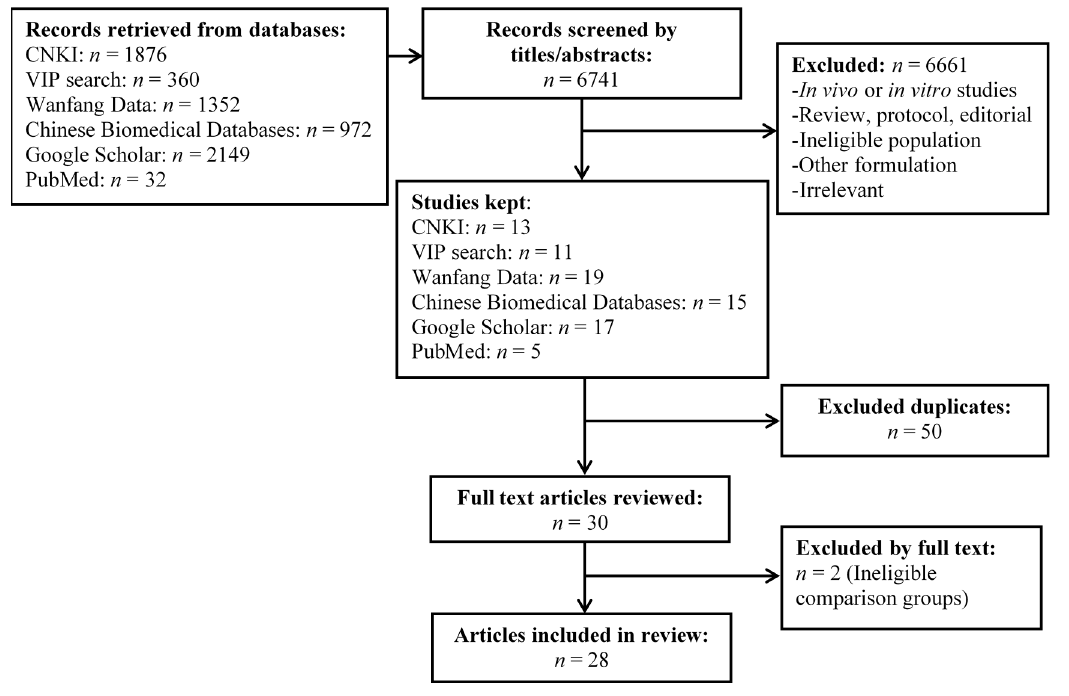
Figure 1. PRISMA flow diagram.